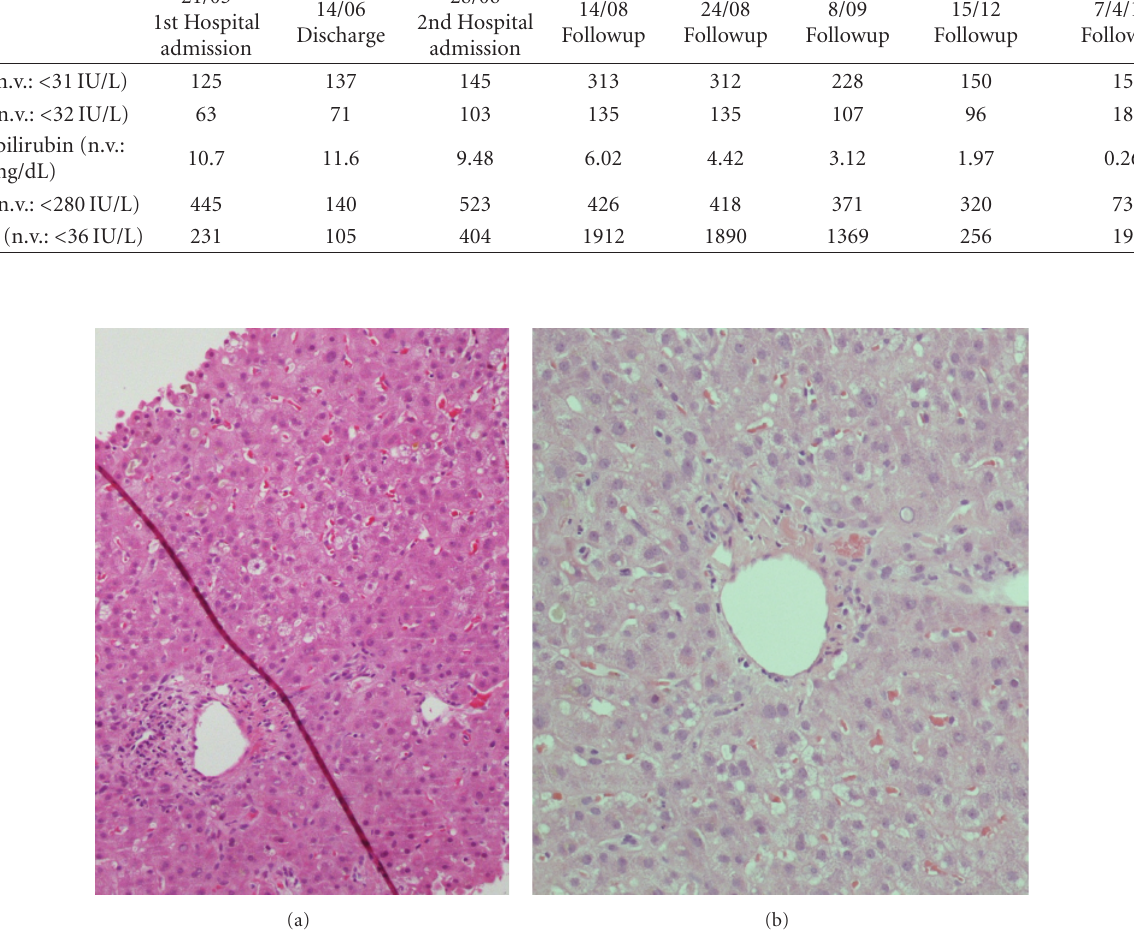
Figure 1: Representative pictures of liver histology at low (a) and high (b) magnification. Description in the